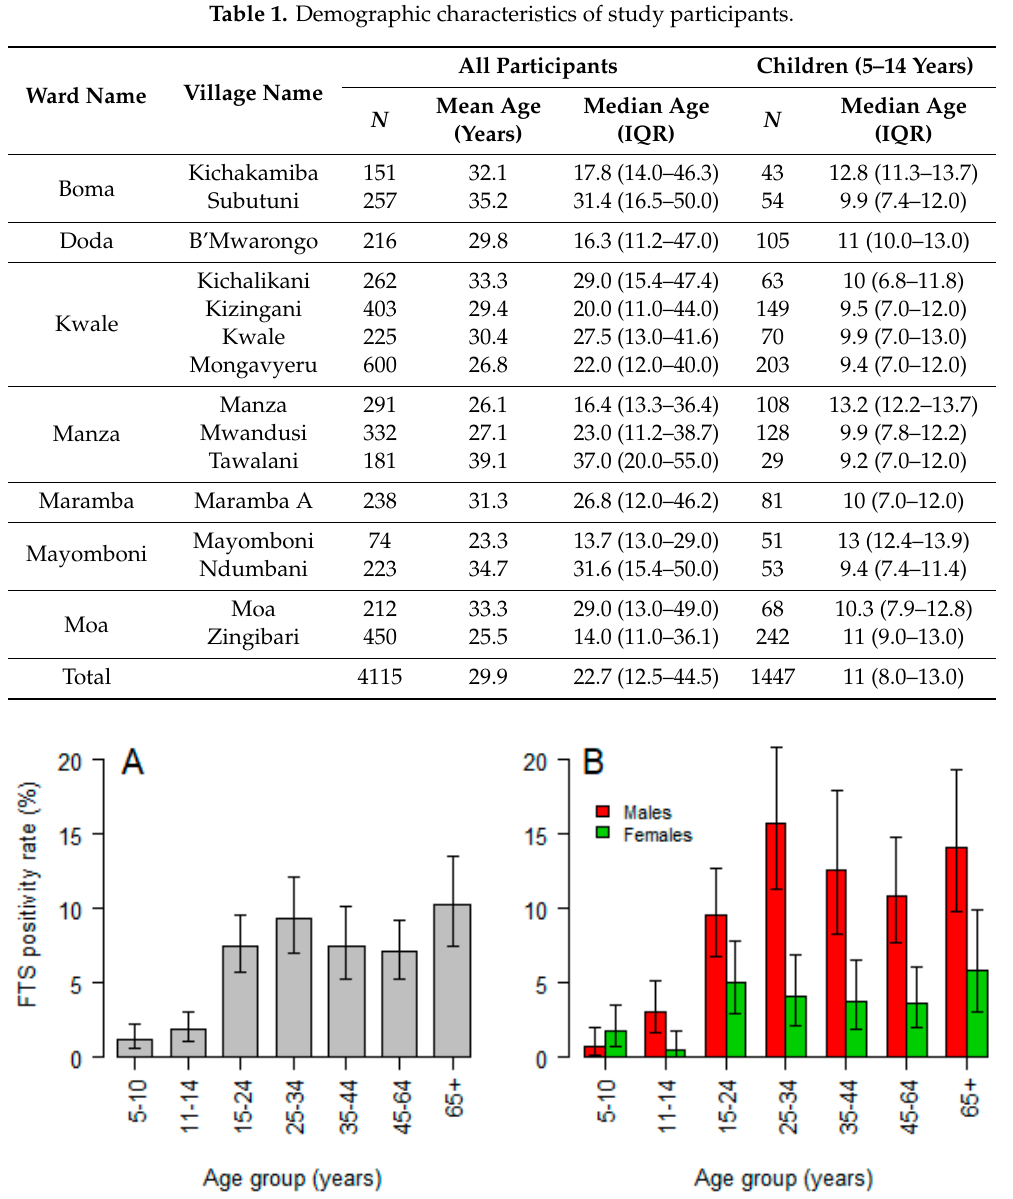
Figure 2 : Prevalence and 95% CI of circulating filarial antigens (CFA) positivity stratified by age group ( A ) and by age group and sex ( B ( A ) and by age group and sex ( B ).